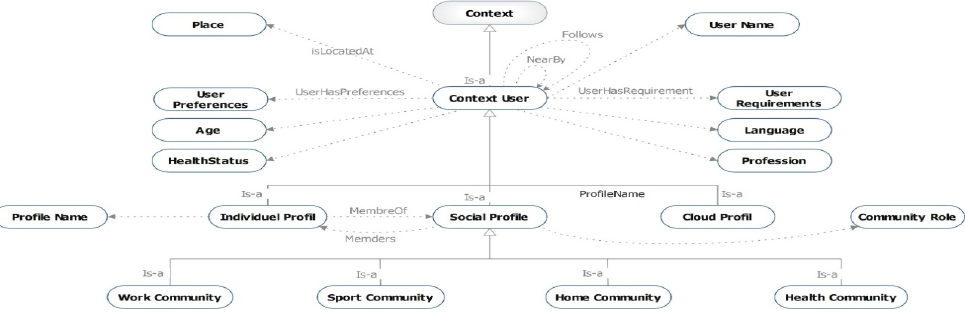
Figure 4. User context sub ‐ ontology.